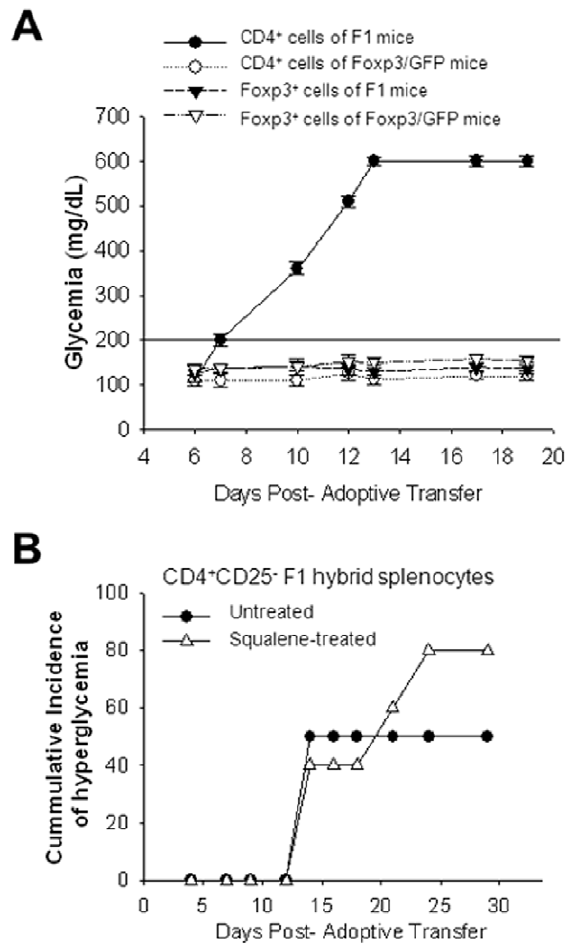
Figure 7. Squalene enrichment of membrane cholesterol fosters the autoreactivity of antigen-specific Th1 diabetogenic cells. ( A ) Diabetogenicity of antigen (HA 110–120 )-specific CD4 splenic Th1 cells was determined in RAG2 KO, RIP-HA mouse model for inducible type 1 diabetes (T1D). The HA 110–120 -specific CD4 splenic T- cells (2 6 10 5 cells) from either F1 mice ( Foxp3 -GFP + / 2 TCR-HA + / 2 mice) (filled circle), or from parental Foxp3 -GFP + / + mice (open circle) were infused alone, or in combination with Foxp3 -GFP sorted splenic cells (2 6 10 5 cells) from Fl mice (filled triangle) or Foxp3 -GFP sorted cells (2 6 10 5 cells) from parental Foxp3 -GFP + / + mice (open triangle) into RAG2 KO, RIP-HA Tg recipient mice (n=5 mice/group). Shown is the mean glycemia values for individual mice in each group 6 SD. Horizontal dark line indicates the upper limit of euglycemia (200 mg/ dL) previously determined in a large cohort of non manipulated RAG2 KO RIP-HA Tg recipients (n=20). Of note, only the antigen (HA 110–120 )- specific CD4 splenic T-cells, but not T-regs or other non-antigen (HA 110– 120 )-specific T-cells were able to induce hyperglycemia in RAG2 KO, RIP- HA Tg recipients. ( B ) Diabetogenicity of antigen (HA 110–120 )-specific CD4 splenic Th1 cells from squalene treated F1 mice was tested in the same RAG2 KO, RIP-HA mouse model for inducible T1D described in panel A. The HA 110–120 -specific CD4 splenic T-cells (2 6 10 4 cells) from squalene treated (180 m g/mouse) or untreated F1 mice were first depleted of Foxp3 + splenic cells 7 days post-squalene treatment, and then infused i.p. in RAG2 KO, RIP-HA Tg recipients. Shown is the cumulative incidence of hyperglycemia (X-axis) from two separate experiments, n=5 mice/group/experiment. Cumulative incidence of hyperglycemia was calculated by dividing the number of mice per group that developed two consecutive readings of hyperglycemia ( . 200 mg/dL) at various intervals of time by the total number of mice and then multiplied by 100.